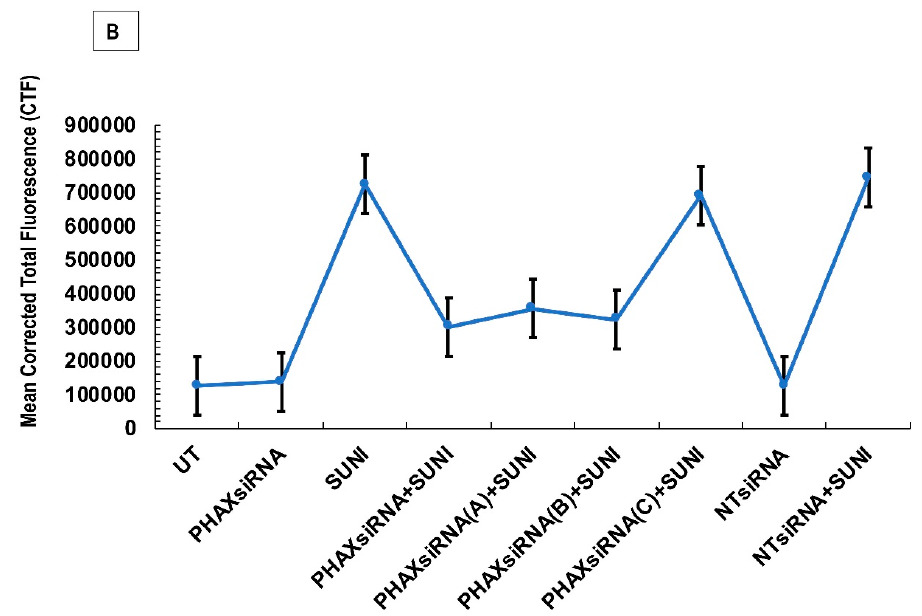
Figure 6. ( A ). Combined immunostaining for PHAX and CD31 in ccRCC organ cultures transfected with a cocktail of PHAX-siRNA; PHAX-siRNA-A, B, C; non-targeting-siRNA (NT-siRNA); and FITC-conjugated siRNA (positive control) prior to treatment with 200 µ M sunitinib for 1 h at 37 ◦ C. ( A ). Untreated (UT) cultures and cultures transfected with PHAXsiRNA alone (without sunitinib) show mild, infrequent PHAX expression in endothelial cells (ECs) in some blood vessels ( arrows ) ( a,b ). In contrast, cultures treated with 200 µ M sunitinib show a strong signal for PHAX in CD31 positive ECs ( arrows ) and in some CD31 negative tumour cells and infiltrating cells ( arrowheads ) ( c ). Cultures pre-treated with a cocktail of PHAXsiRNA (pool of three target-specific siRNAs) ( d ) or PHAXsiRNA-A ( e ) or PHAXsiRNA-B ( f ) show a diminished level of PHAX expression, with only a mild infrequent signal seen. PHAXsiRNA-C ( g ) show the same intensity and frequency of staining as cultures treated with sunitinib alone ( c ). Cultures stimulated with NTsiRNA showed a few CD31 negative tumour cells ( arrowheads ), and some CD31 positive ECs ( arrows ), ( h ) while cultures treated with NTsiRNA followed by sunitinib show a strong signal for PHAX in CD31 positive ECs ( shaded arrows ), in infiltrating cells ( open arrows ) and some tumour cells ( arrowheads ) ( i ). Positive controls using FITC-conjugated siRNA showed green fluorescence-labelled cells within the tissue ( arrows ), confirming optimisation of siRNA delivery conditions ( j ). ( B ). Quantification of the mean signal intensity for PHAX protein using Image J calculated as corrected total fluorescence (CTF) in ccRCC organ cultures. Abbreviations: cocktail of